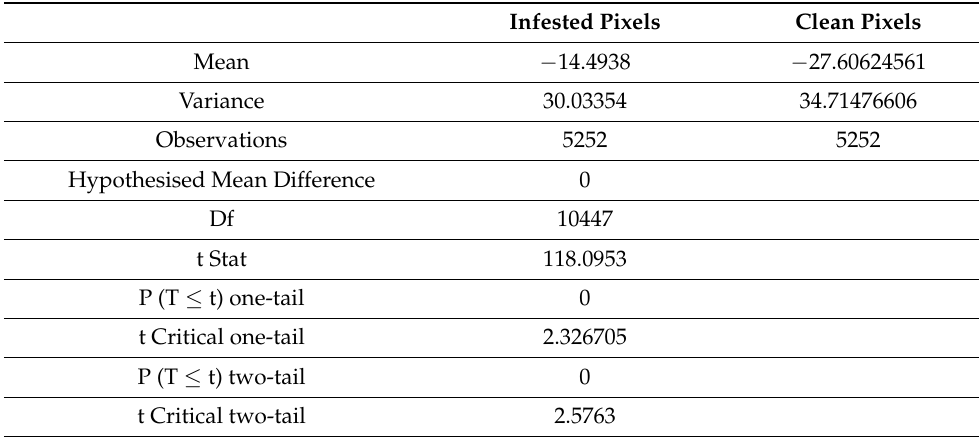
Table 2. Summary of t-test results, comparing clean (2019-11-02) and infested (2020-01-19)